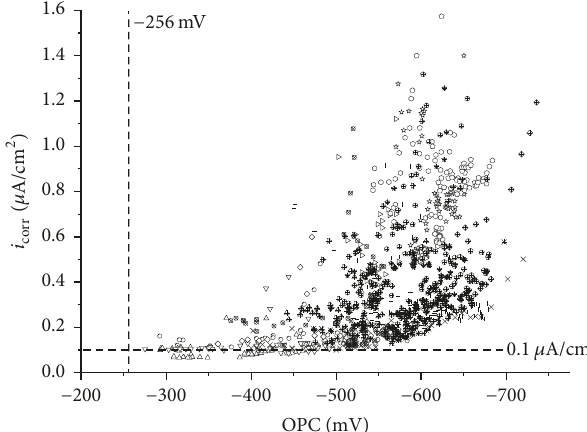
Figure 12: Relationship between the corrosion rate and the open circuit corrosion